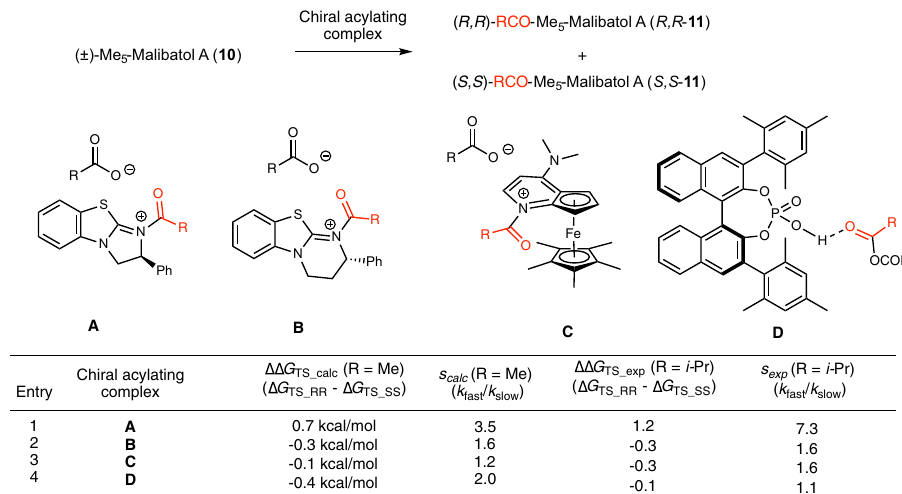
Fig. 4 DFT calculations of kinetic resolution. Scope of kinetic resolution system and experimental validation for the calculation